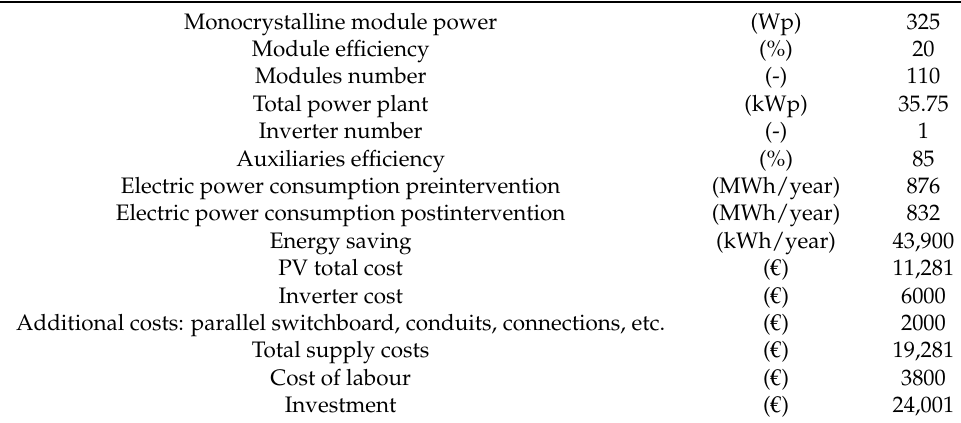
Table 9. Photovoltaic system characteristics.